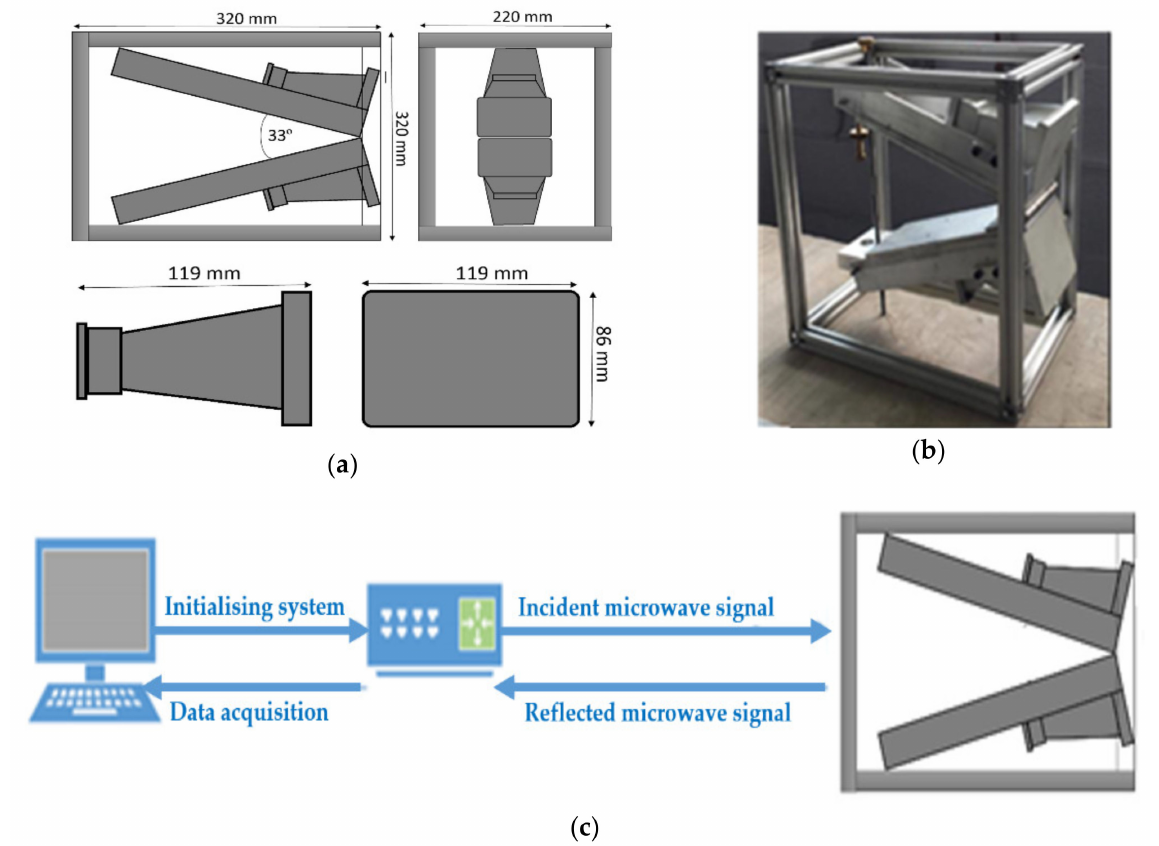
Figure 1. ( a ) Sensor dimensions, ( b ) Proposed microwave Transmitter/Receiver setup and ( c ) block diagram of proposed Sweep Frequency system for SHM